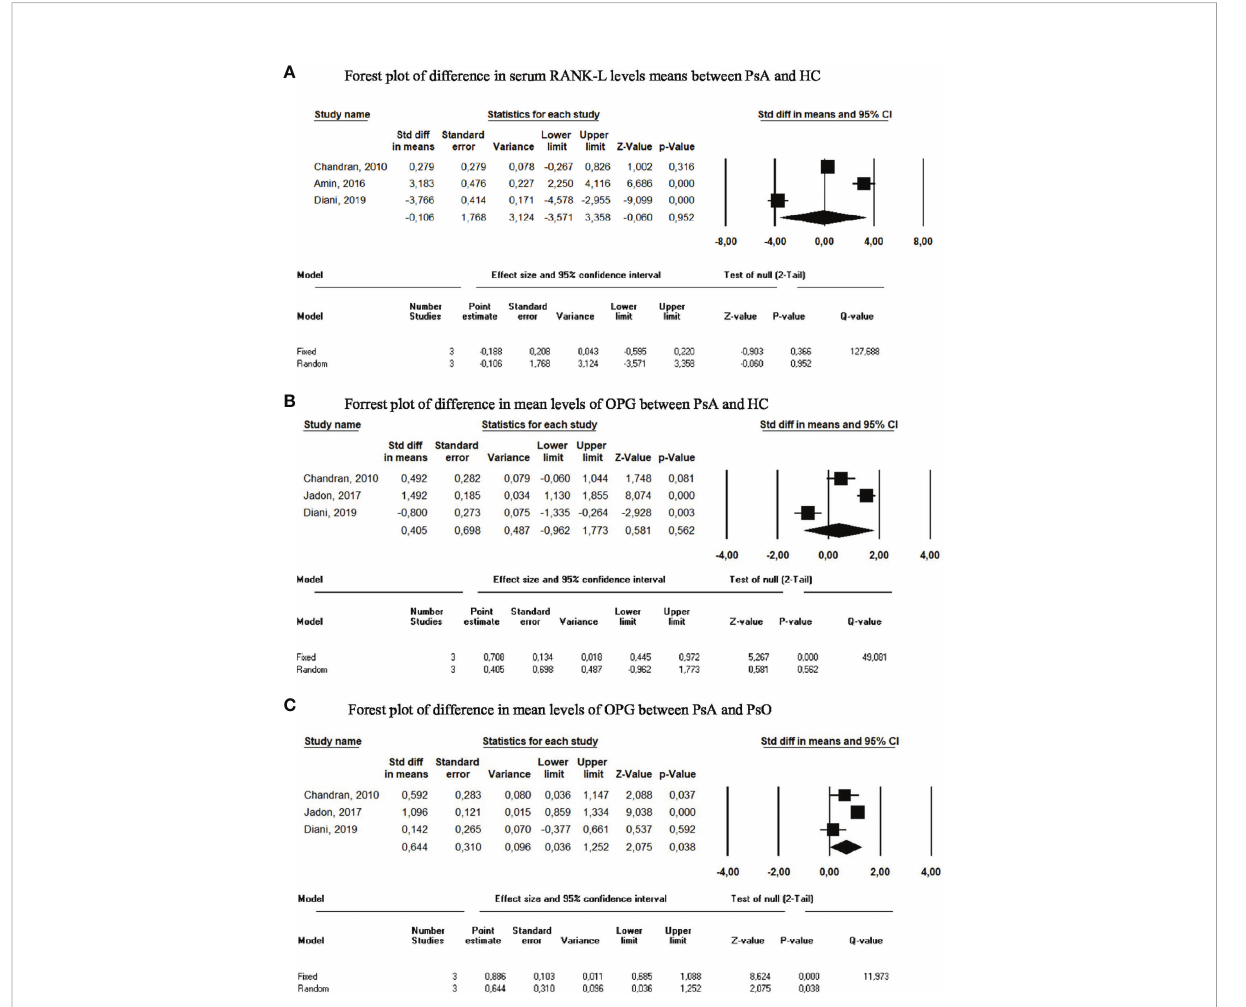
FIGURE 4 Meta-analysis of circulating biomarkers. (A) Forest plot of difference in serum RANK-L levels means between PsA and HC. (B) Forrest plot of difference in mean levels of OPG between PsA and HC. (C) Forrest plot of difference in mean levels of OPG between PsA and PsO.